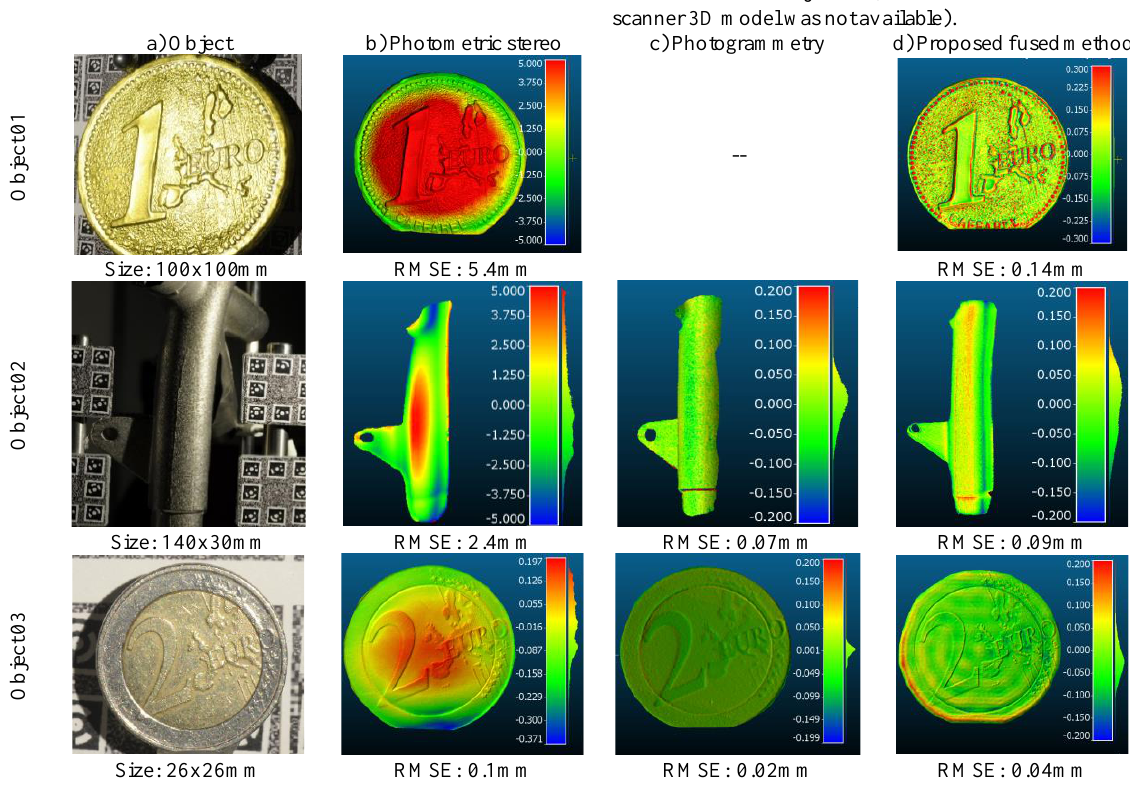
Figure 4. The result of the cloud-to-cloud comparison with reference data for photometric stereo, photogrammetry and proposed method on three non-collaborative